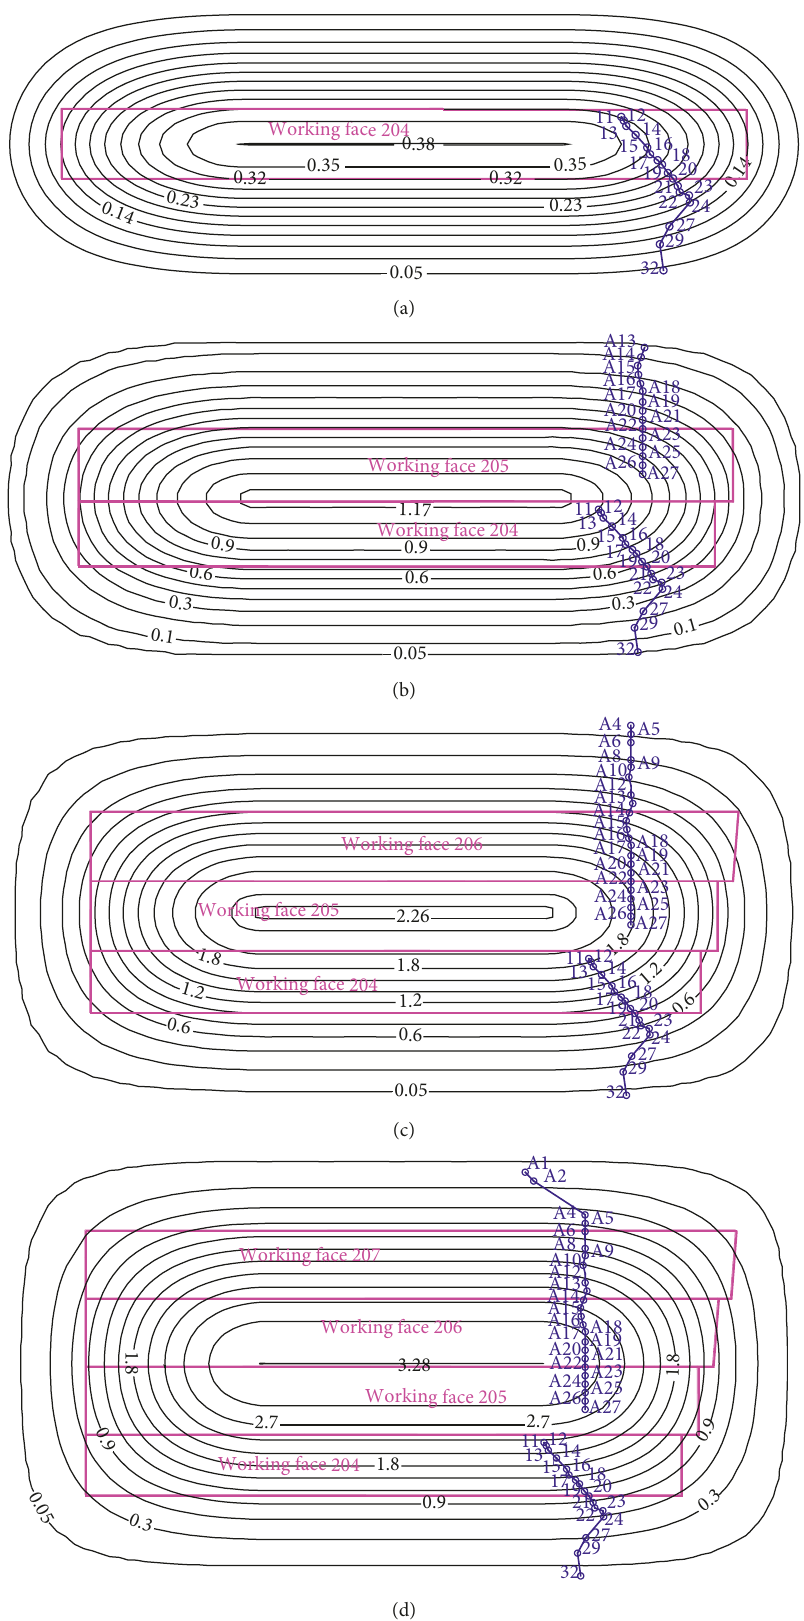
Figure 8: Subsidence contour maps after the mining of working faces 204, 205, 206, and 207, respectively, in the second panel. (a) After the mining of working face 204. (b) After the mining of working faces 204 and 205. (c) After the mining of working faces 204, 205, and 206. (d) After the mining of working faces 204, 205, 206, and